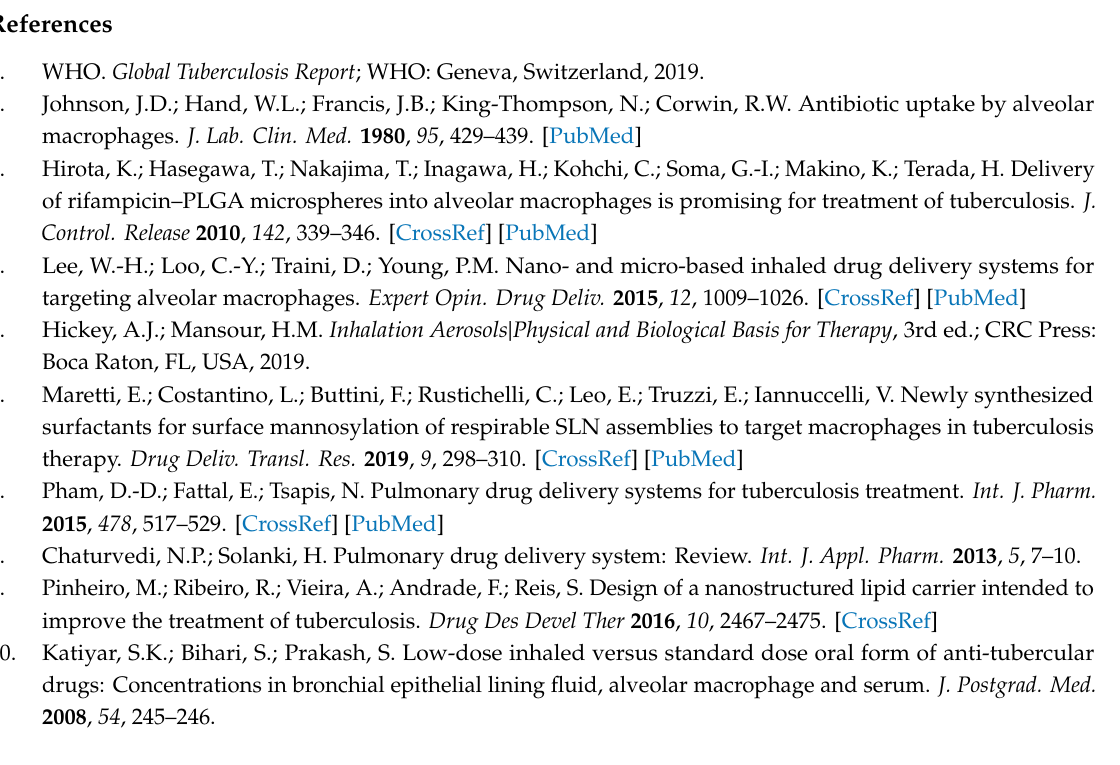
Figure S1: Representative fluorescence microscopy images of lung dissections at 24 h post-exposure. Pictures were taken with a 20 × magnification. From left to right, first frame: images taken using the filter for Hoechst label (cells), second frame: images taken using the filter for IR-780 label (SLNas), third frame: merge, showing lungs cells in blue and SLNas in red. Scale bars = 100 µ